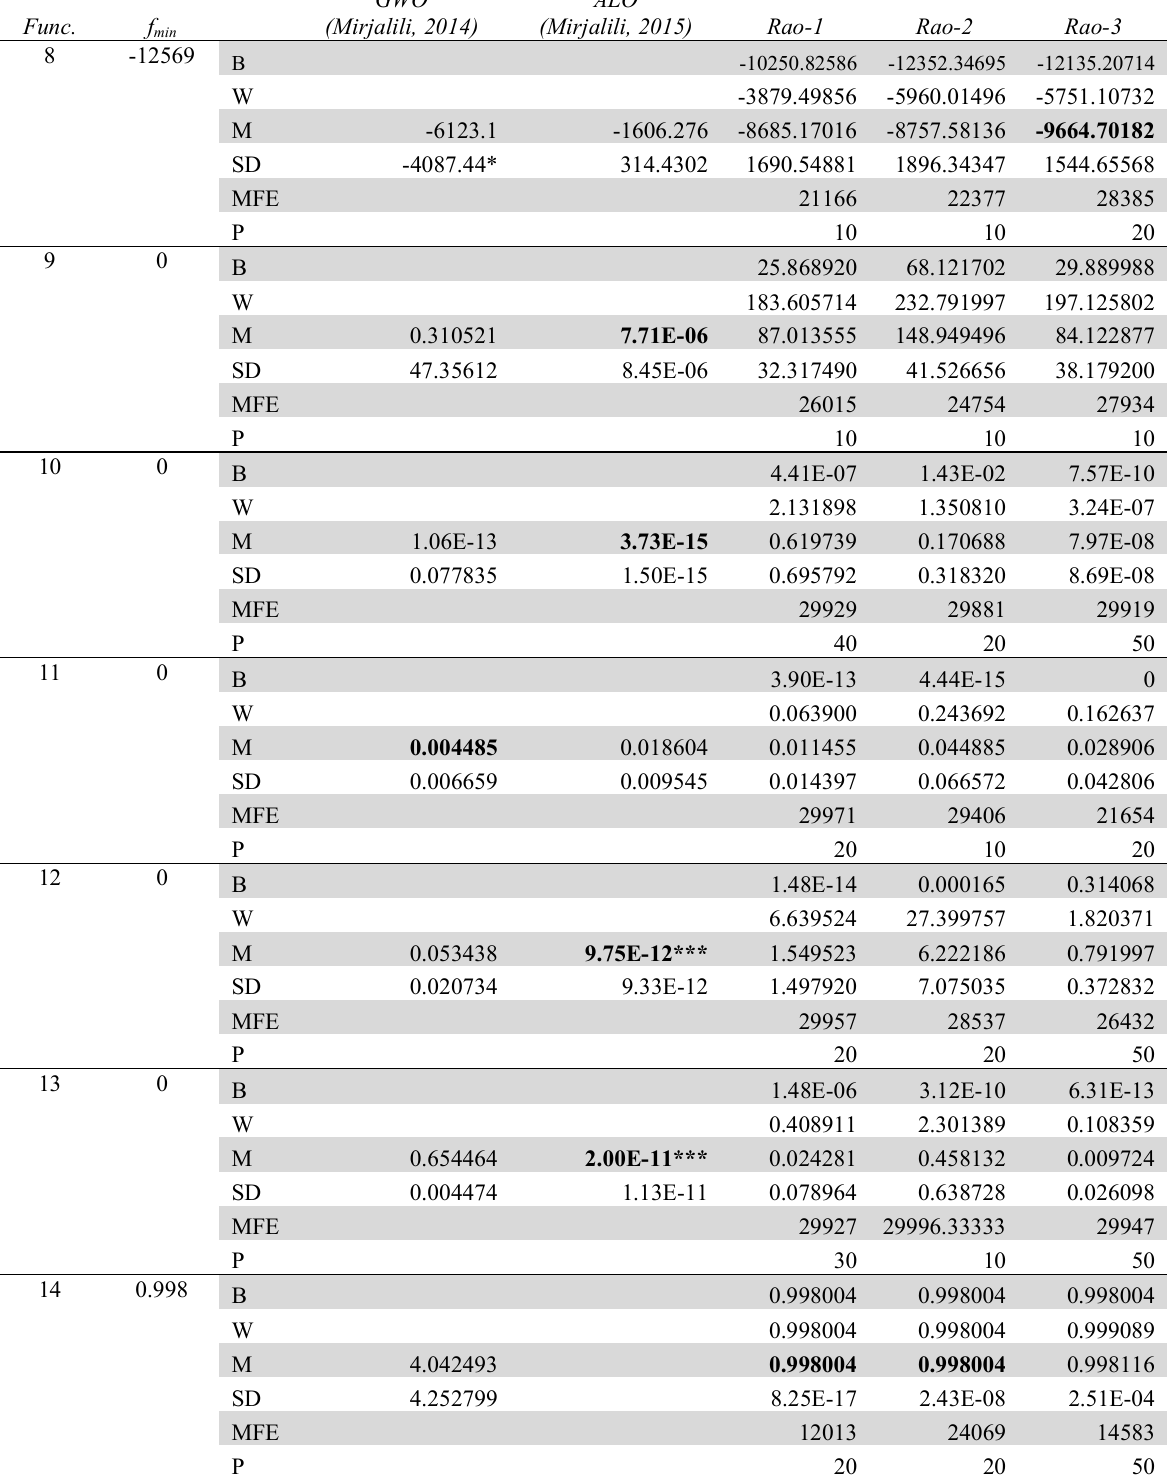
Results of the proposed algorithms for 23 benchmark functions considered (30000 function evaluations)